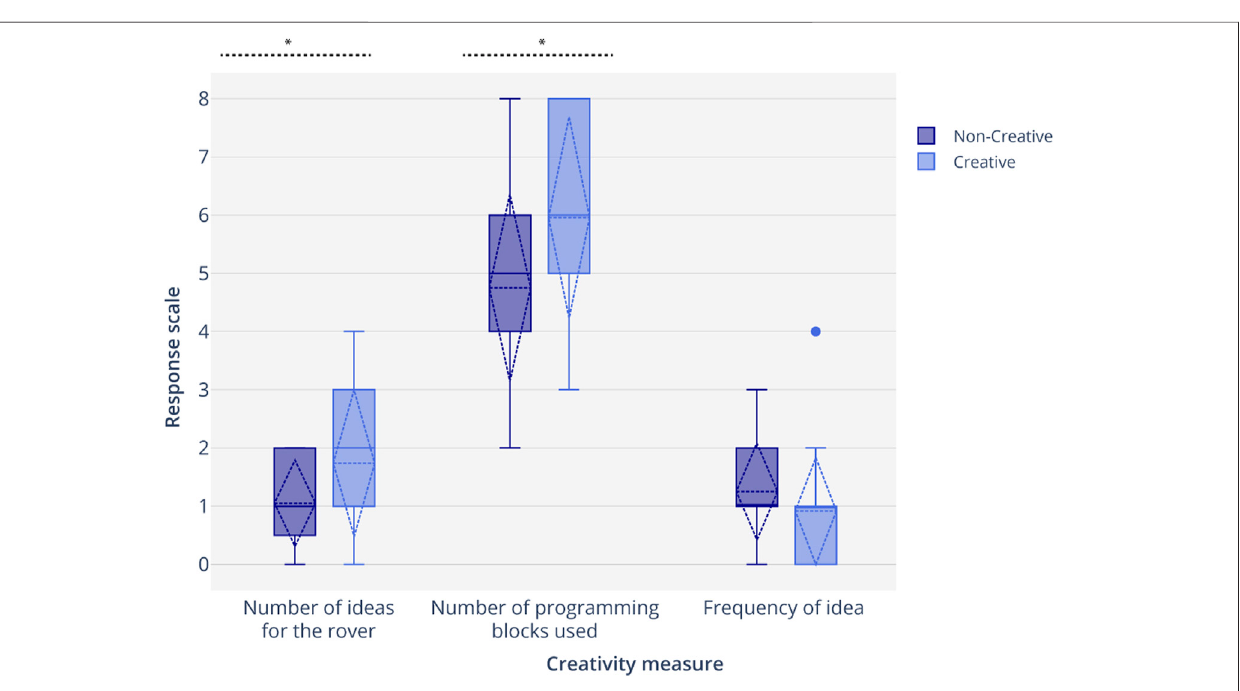
FIGURE8| ParticipantsintheHighcreativerobotcondition(C+)generatedasigni fi cantlyhighernumberofideasthanintheLowcreativerobot(C − )condition(H1). Participants in the C+ condition used a signi fi cantly higher number of programming blocks than participants in the C − condition (H2). There was no signi fi cant difference in the frequency of ideas generated in the two conditions